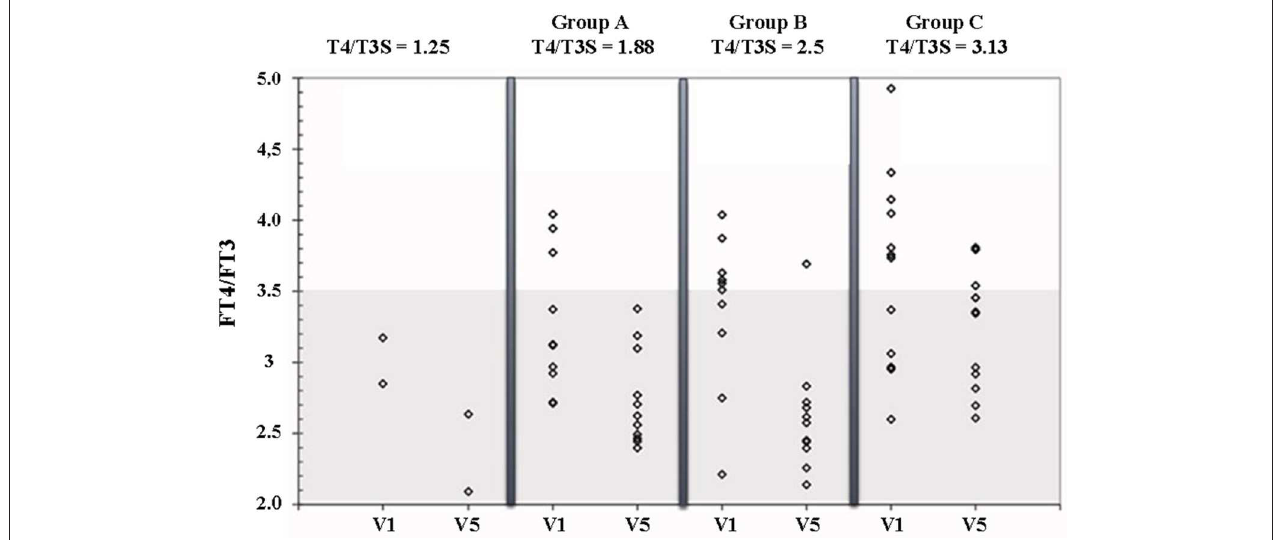
FIGURE 3 | FT4/FT3 ratio in patients on L-T4 treatment (V1) and on L-T4 T3S (V5). The various groups are labeled according to the T4/T3S ratio of their treatment + regimen: group A 1.88, group B 2.5, group C 3.13. The 2 patients from group A and group B, who had to increase the T3S dose to 60 and 80 µ g, respectively, = = = are indicated as receiving a T4/T3S ratio 1.25. The shaded area represents the 95% reference range for the FT4/FT3 ratio in the normal euthyroid population. =